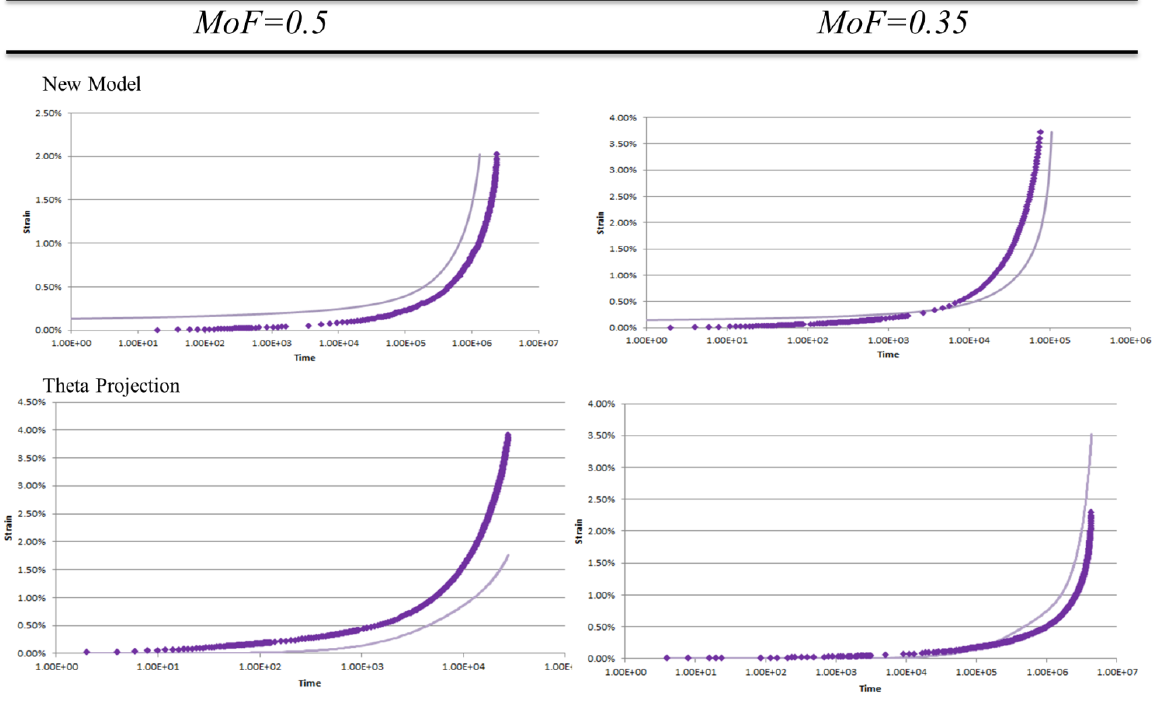
Figure 2. Examples of MoF = 0.5 & 0.35 for New Model and Theta Projection on logarithmic scale. Experimental data ( ♦ ) model prediction ( ▬